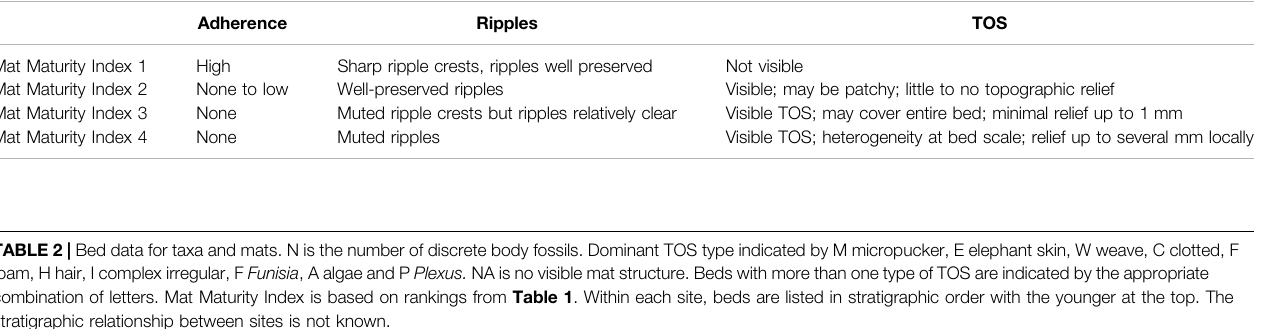
TABLE 1 | Criteria for the ranking of original mat maturity.